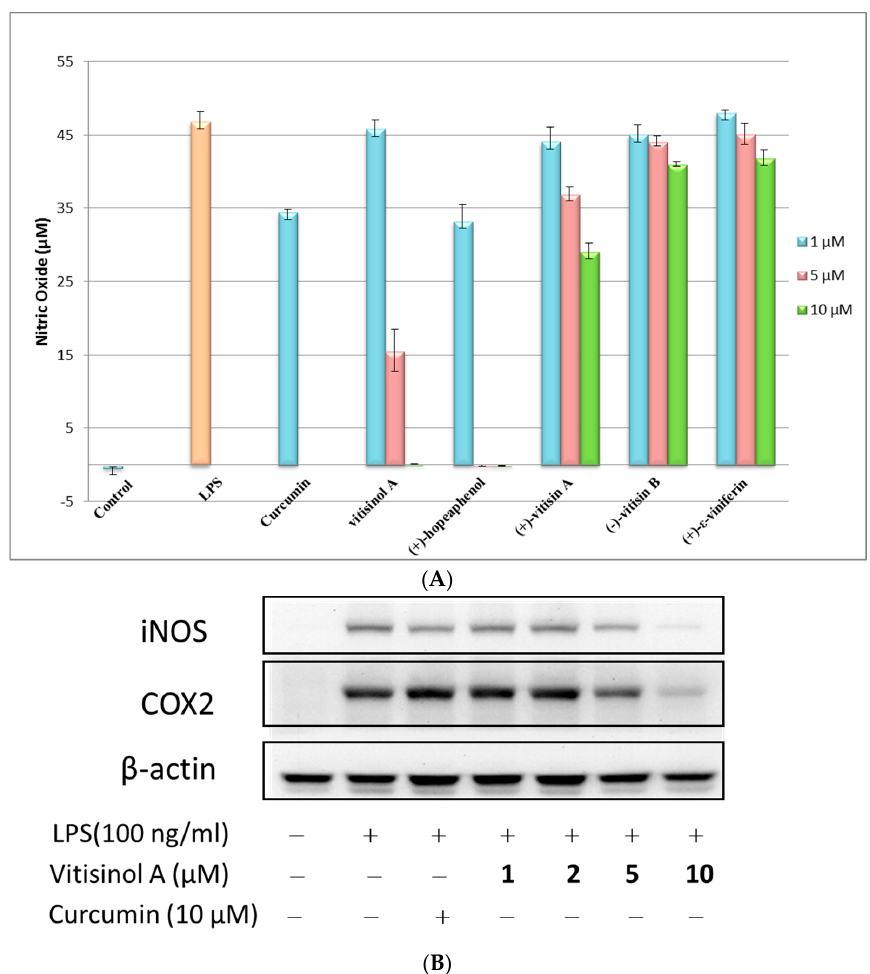
Figure 3. Anti-inflammatory effect of vitisinol A and its comparison with other four resveratrol oligomers. ( A ) Effect of five oligostilbenes on nitric oxide (NO) production at 1.5 and 10 μ M in lipopolysaccharide (LPS)-activated RAW264.7 cells; ( B ) Effect of vitisinol A on inducible nitric oxide synthase (iNOS) and cyclooxygenase-2 (COX2) expression in LPS-induced RAW 264.7 macrophage cells. The experimental details are shown in Materials & Methods.